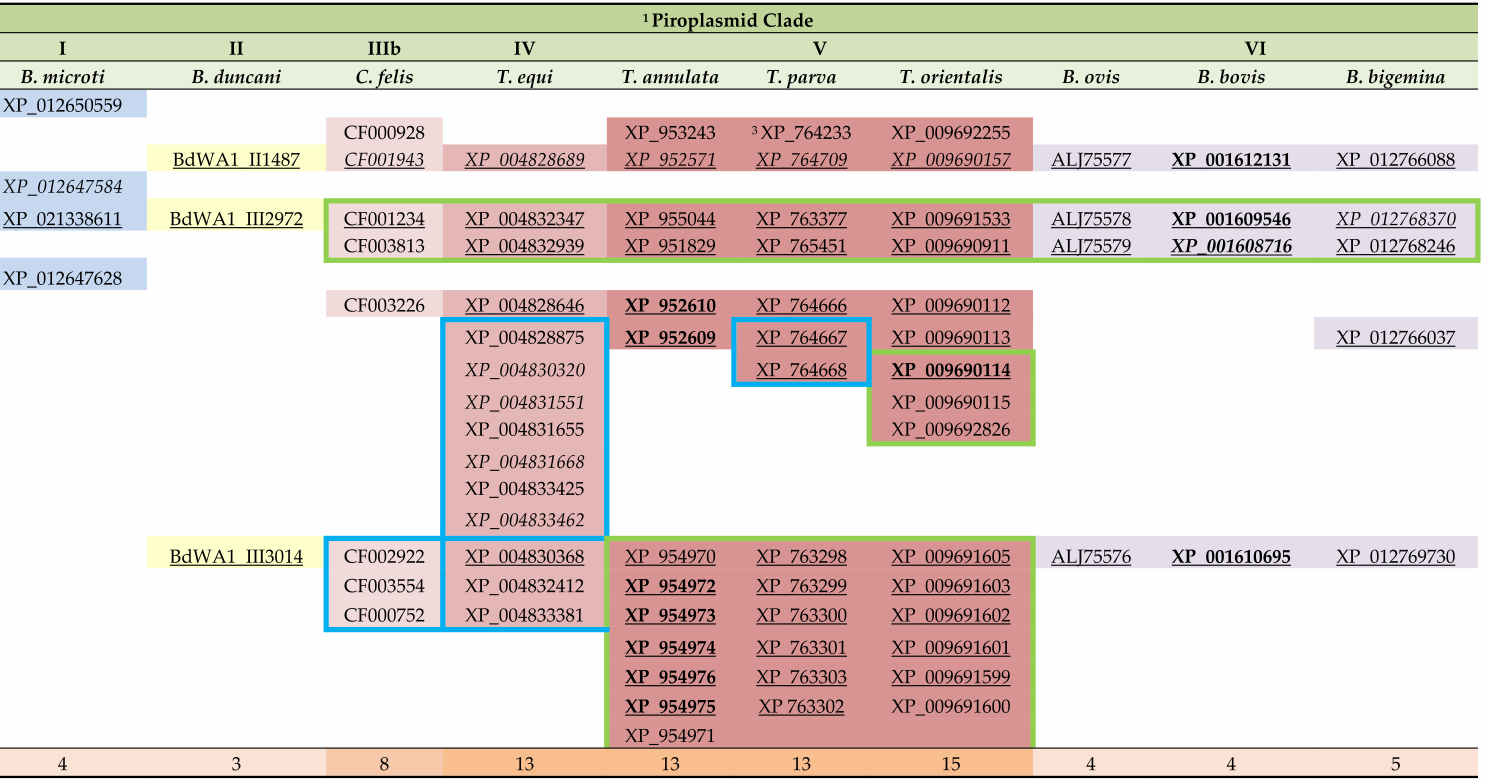
Table 2. Assignment of C1A cysteine proteinase sequences to Babesia , Theileria , and Cytauxzoon species and